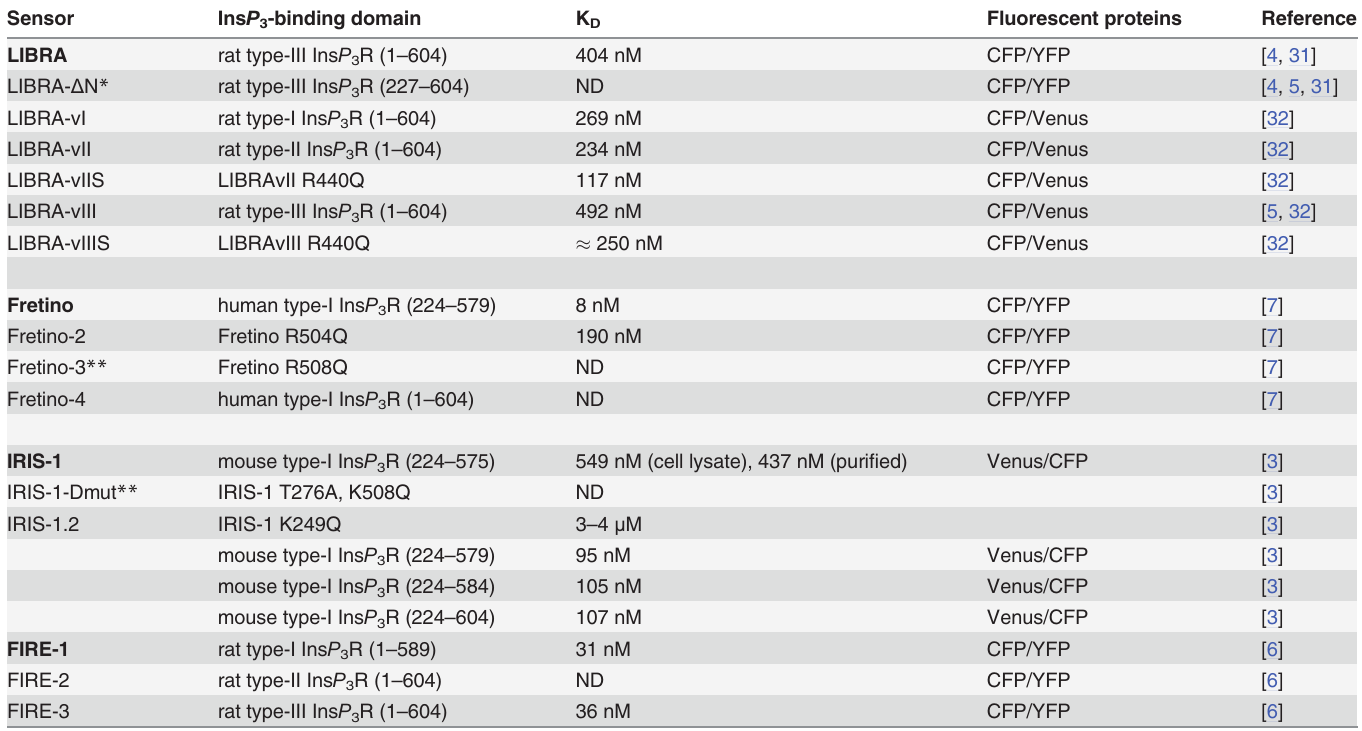
Table 1. Ins P 3 sensors in use for single-cell fluorescent energy transfer-based applications.